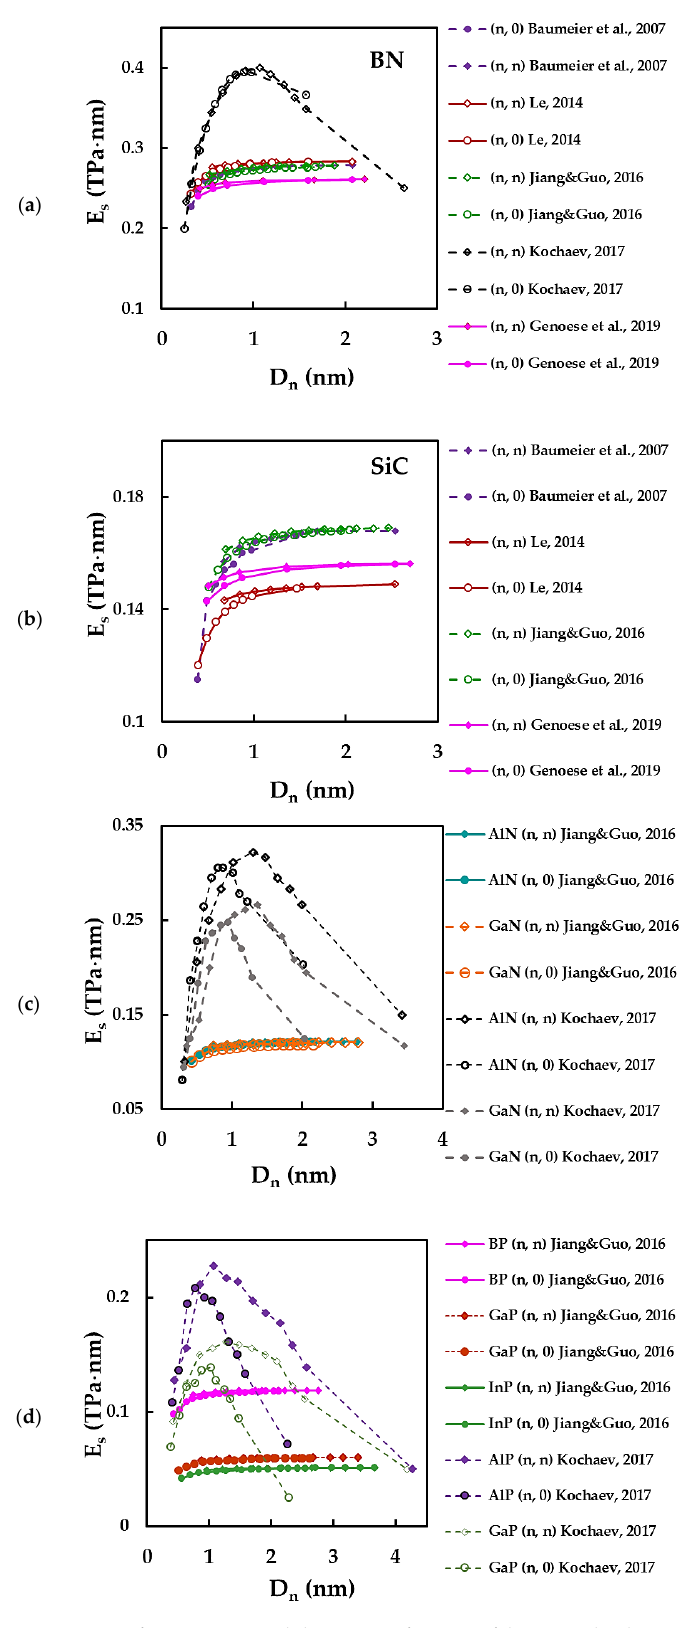
Figure 5. Surface Young’s modulus, E s , as a function of the nanotube diameter, D n , for ( a ) BNNTs [37,39,41,43,46], ( b ) SiCNTs [39,41,43,46], ( c ) AlN [37,39], GaNNTs [37,39], ( d ) AlP [37], GaP [37,39], BP [39], InPNTs [39].